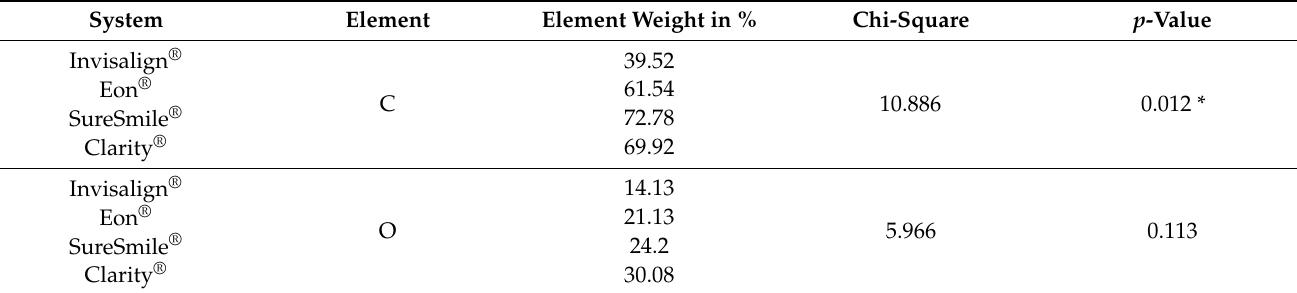
Table 3. Chi-square analysis of the main elements presented in all four